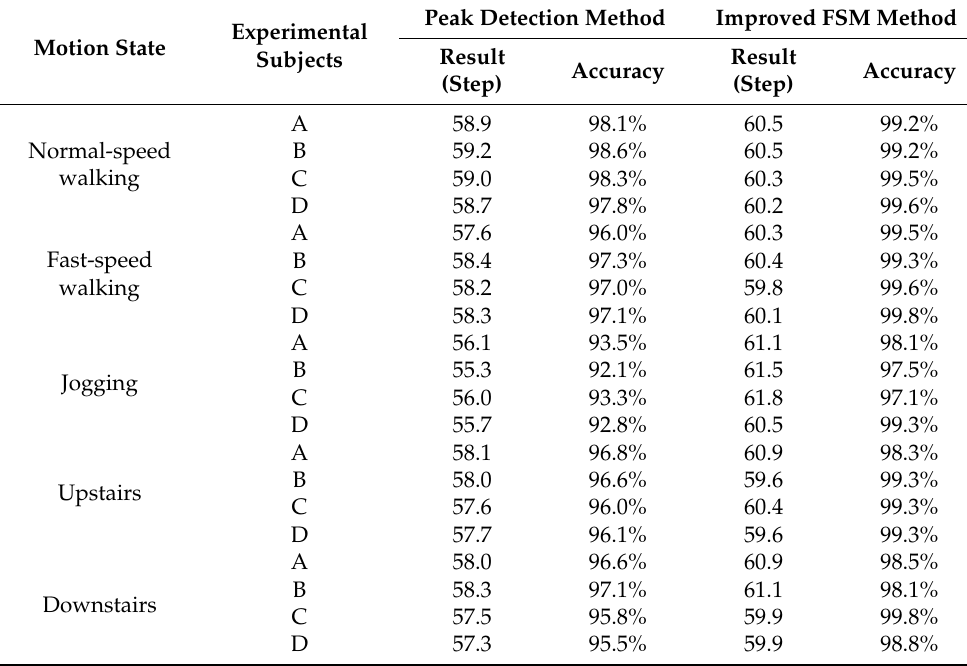
Figure 12. The successful rate of gait detection. Table 3. Gait detection results of 20 experiments under different motion